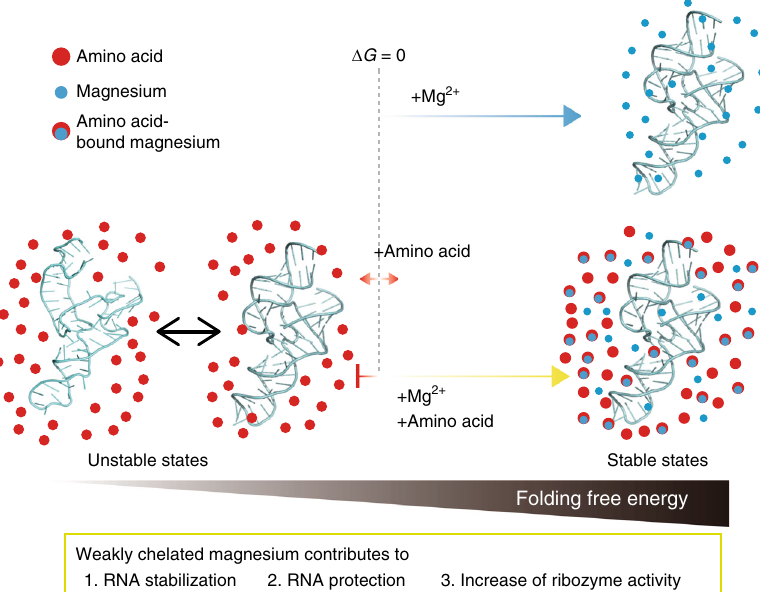
Fig. 6 Proposed effects of weakly chelated magnesium on RNA. Illustration of the effects of amino acids and aaCM for RNA. Amino acids alone increase the folding free energy of RNA, either having no effect or destabilizing the RNA. At the same time, aaCM decreases the folding free energy of RNA, stabilizing the RNA and promoting high catalytic